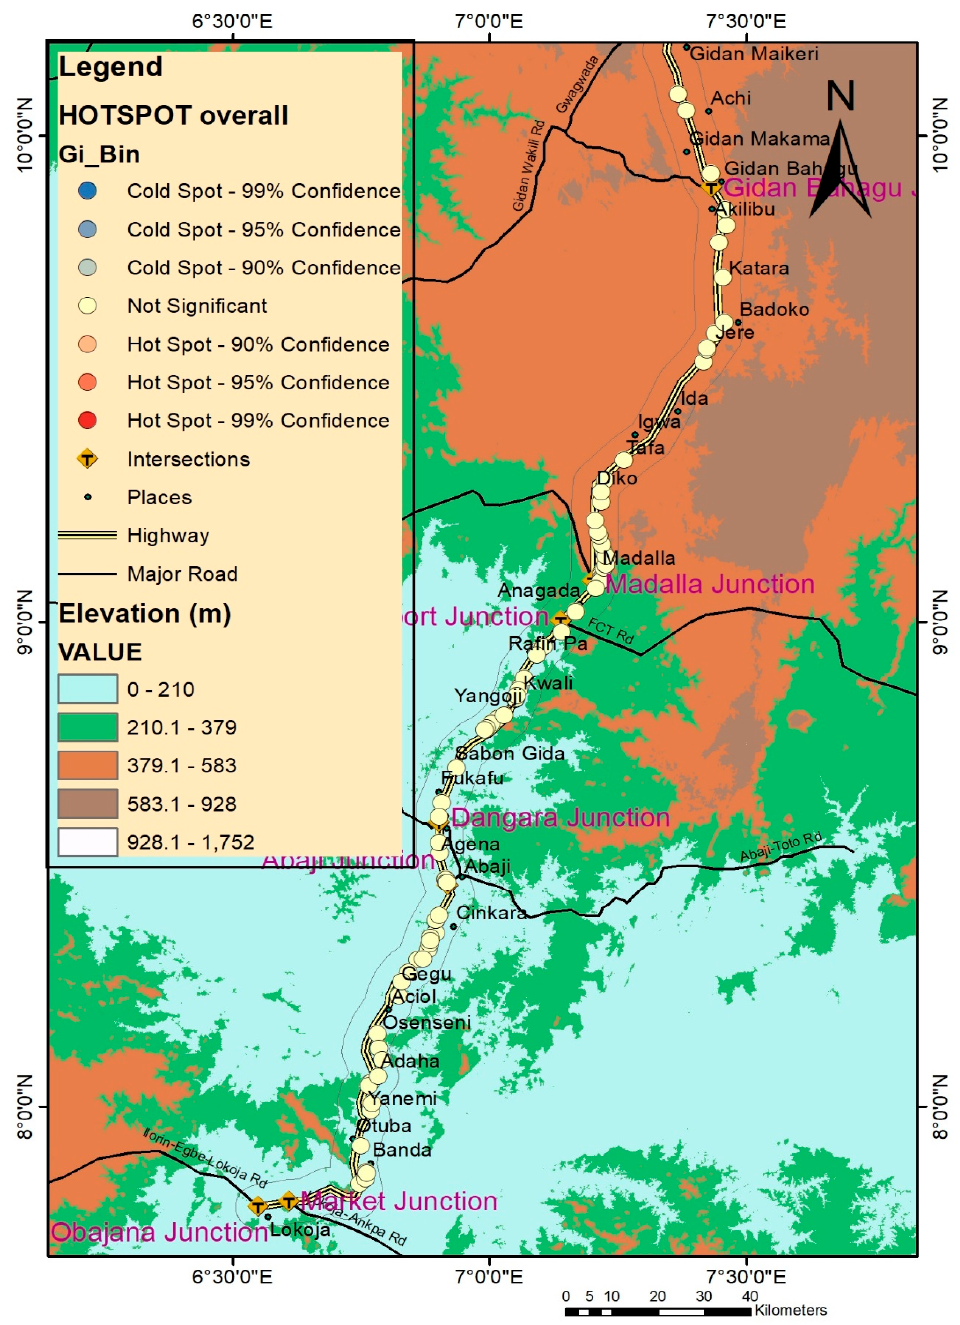
Figure 6. Overall hotspot analysis for the 5 years (2013 to 2017).